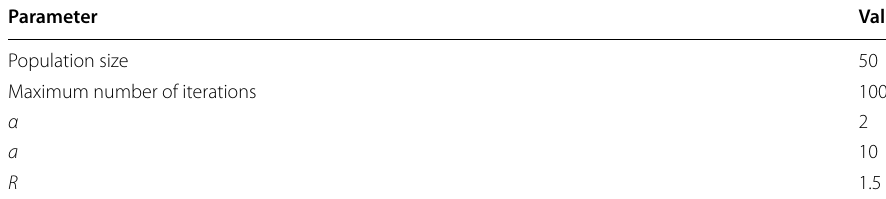
Table 1 Parameters of the BSE algorithm